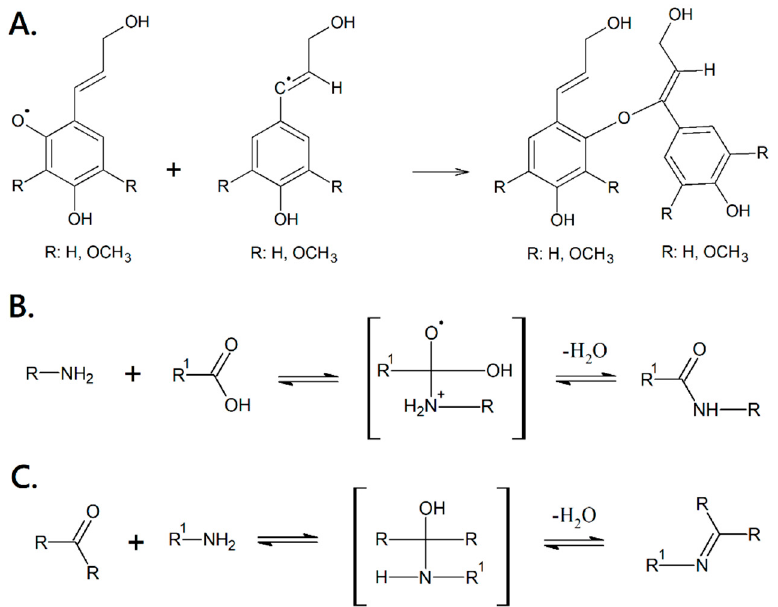
Figure 6. Lignin interactions and reactions between lignin and glycine. Intermolecular interactions between lignin radicals ( A ). Reaction mechanism in the formation of amide ( B ) and imine ( C ) groups after the reactions between lignin and glycine (see the previous sections for rationale). R represents the lignin radicals while R 1 refers to the amino acid structure (in this case glycine). The authors are